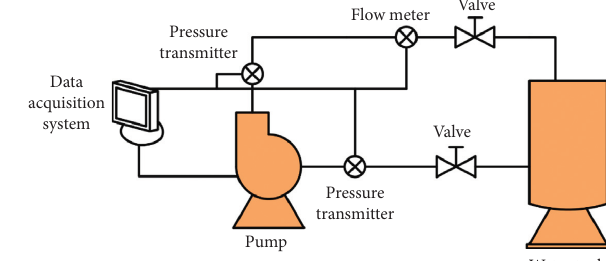
Figure 3: Schematic of experimental apparatus.